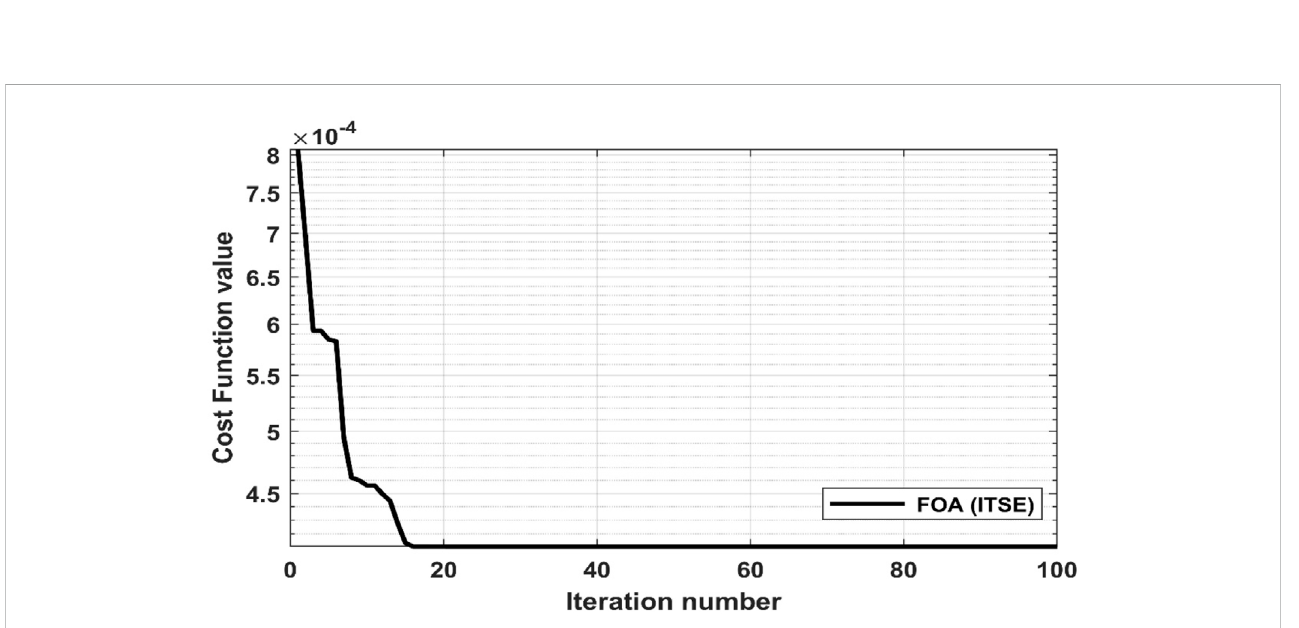
FIGURE 7 Convergence diagram for Fox Optimizer